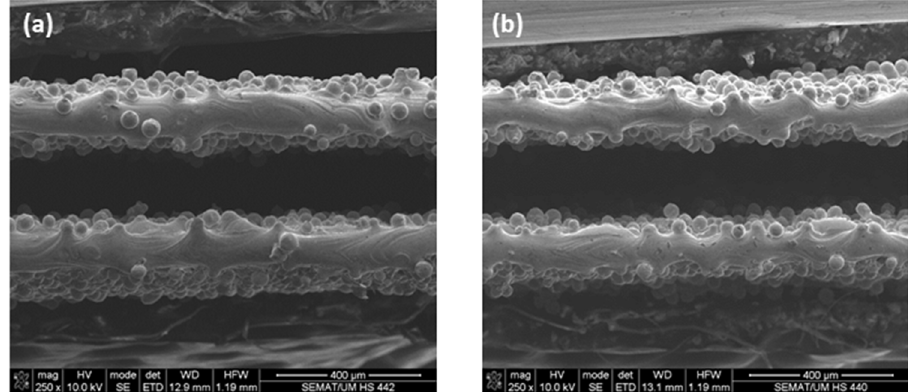
Figure 12. Central part image of thin-walled tubes built in experiment numbers ( a ) 17 (100 W/300 mm/s) and ( b ) 21 (100 W/1250 mm/s).